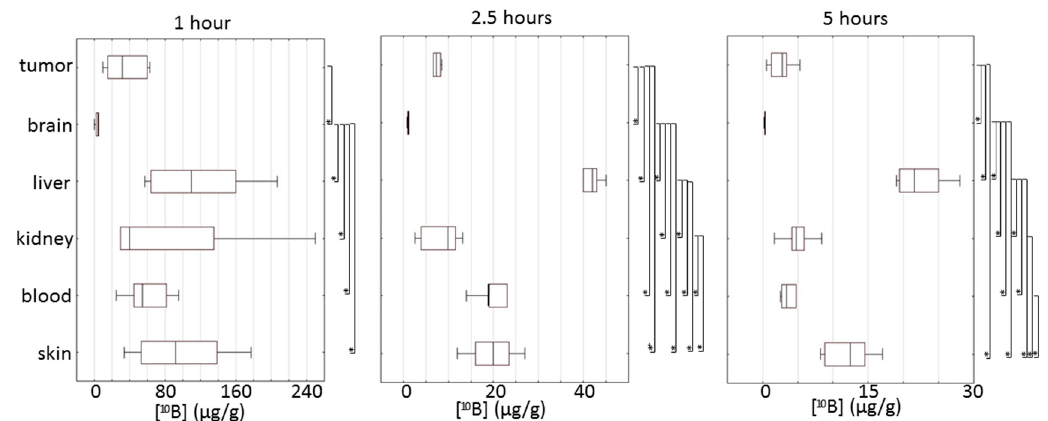
Figure 4. Box plots of absolute concentration of boron in different tissues at 1, 2.5 and 5 h after BSH injection. Box borders indicate 25th and 75th percentiles; lines within boxes indicate the median. Significance of differences for 10 B uptake in tissue was defined by Mann–Whitney pairwise comparison followed by a Bonferroni post-test. * Statistical difference at p < 0.05.